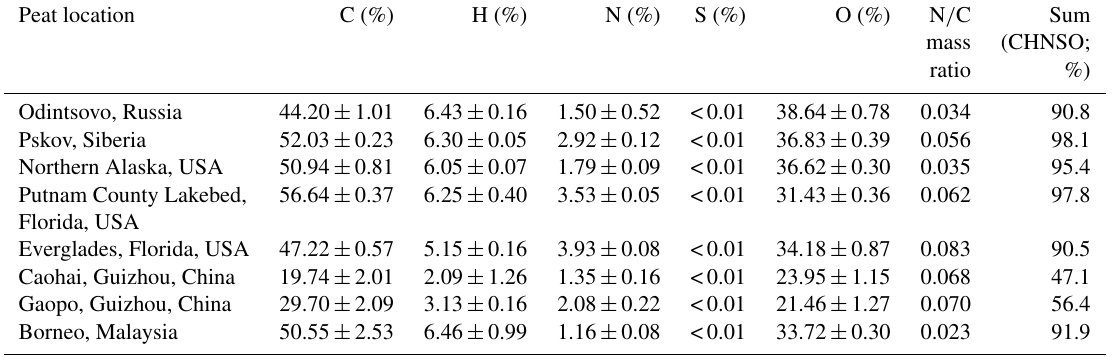
Table 1. Average peat composition ∗ (dry weight percentage) for total carbon (C), hydrogen (H), nitrogen (N), sulfur (S), and oxygen (O). Peat location C (%) H (%) N (%) S (%) O (%) N / C Sum